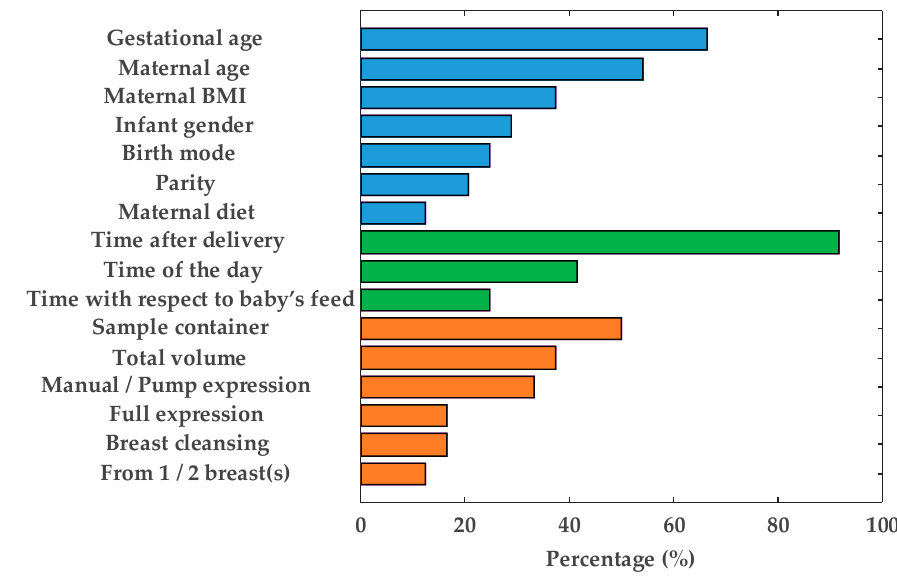
Figure 2. Reporting frequency of factors relevant to the human milk (HM) sampling process: Maternal-infant-related factors (blue bars), time-related factors (green bars), and HM collection-related factors (orange bars). Note: BMI = body mass index.